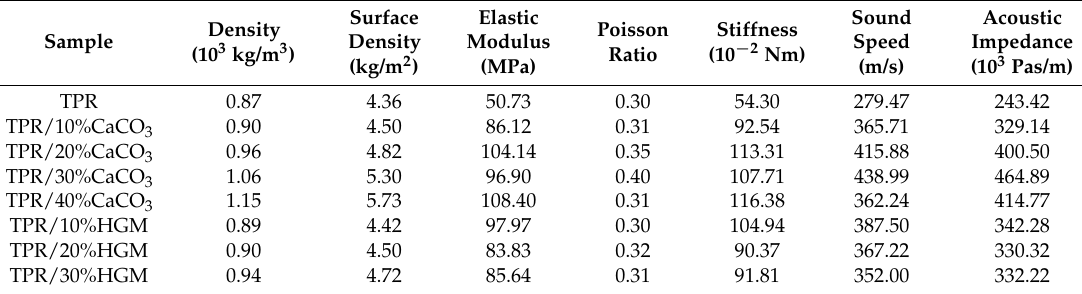
Table 2. Mechanical and acoustic parameters of PP, EPDM (Ethylene propylene diene monomer) and different TPR composites.